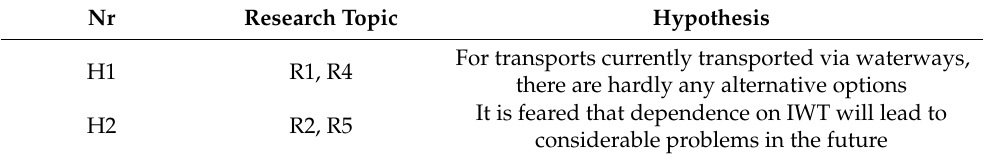
Table 7. Exemplary